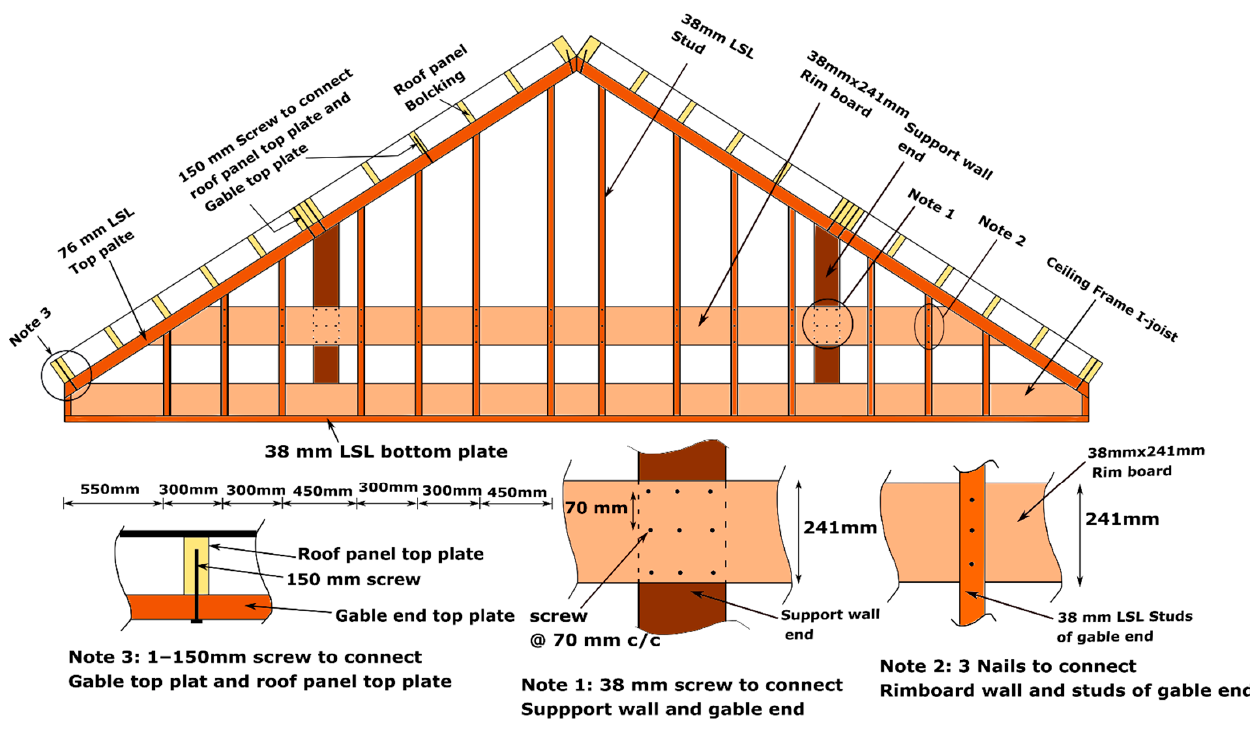
Figure 5. Connection-G and H.